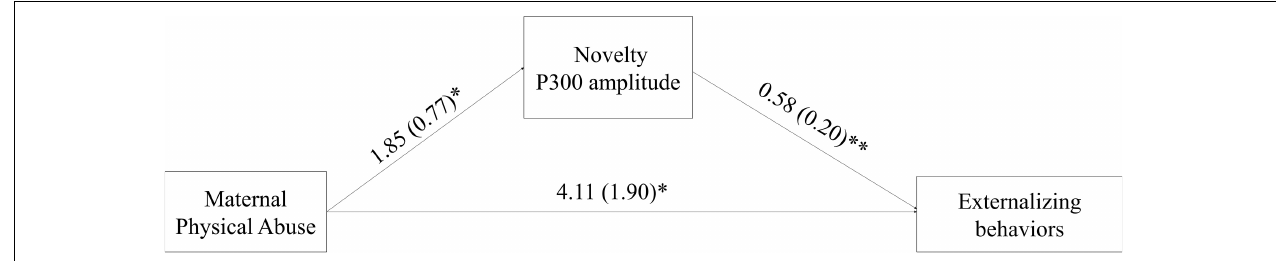
FIGURE 2 | The final mediation model with path coefficients. The model illustrates that novelty P300 amplitude mediated the relationship between maternal physical abuse and self-report externalizing behaviors. ∗ , p < 0.05; ∗∗ p < 0.01.